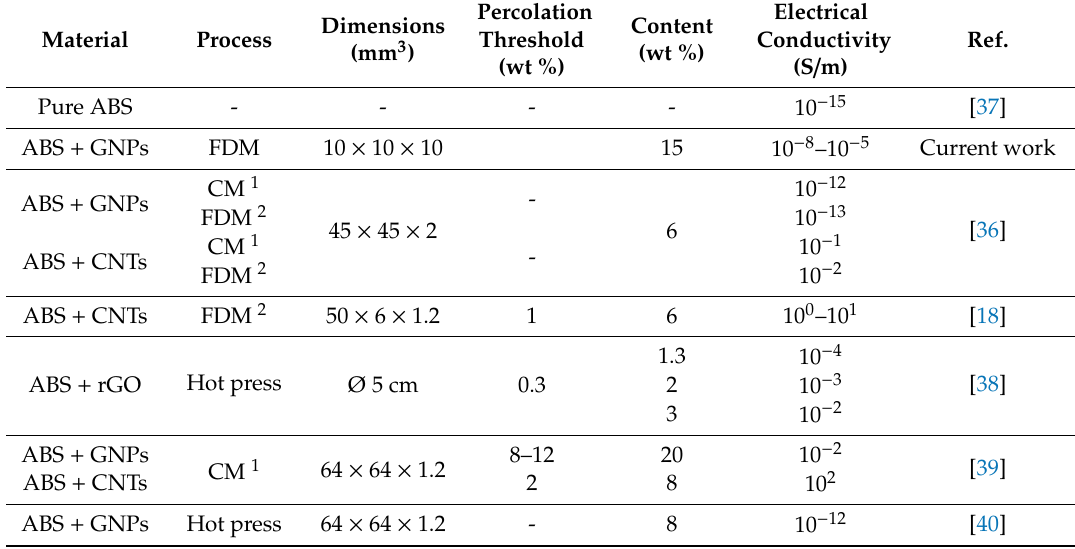
Table 4. Electrical conductivity of ABS-matrix nanocomposites.